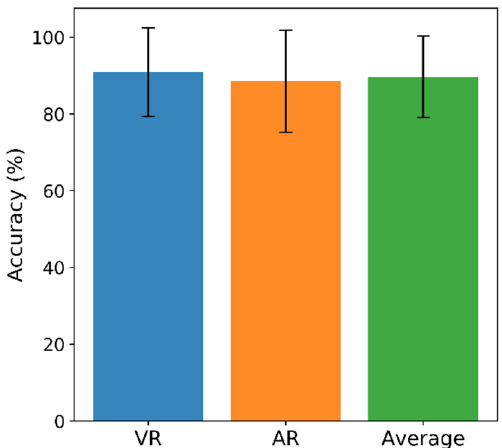
Figure 7. Mean accuracy and standard deviation are presented for VR (blue), AR (orange), and the mean of VR and AR (green). No significant difference was observed ( p > 0.05).